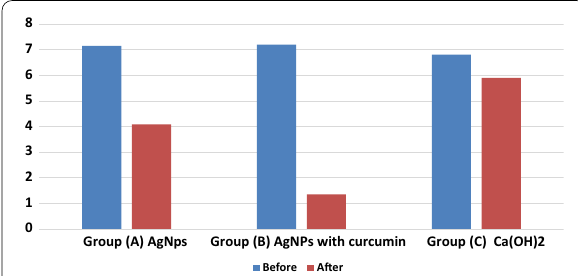
Fig. 8 Bar chart representing antibacterial activity for tested groups